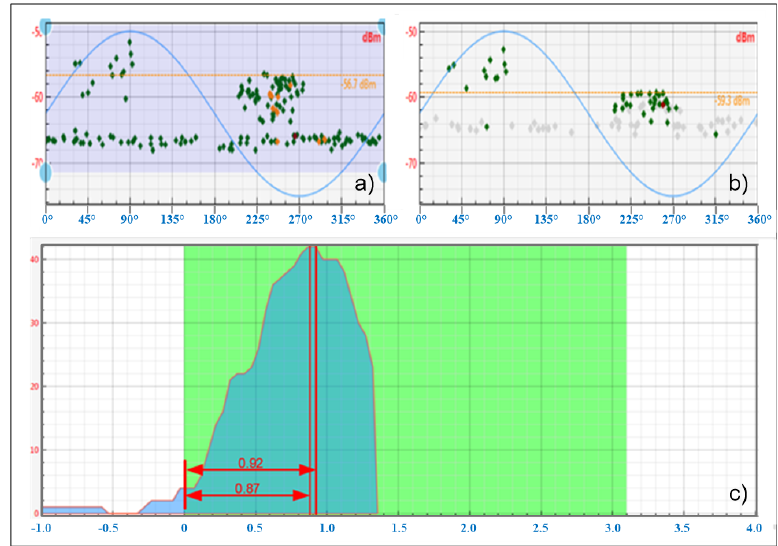
Figure 14. The distance of the PD source obtained from the two AE sensors. ( a ) partial discharge from AE1 ( b ) partial discharge from AE2 ( c ) distance of sensor